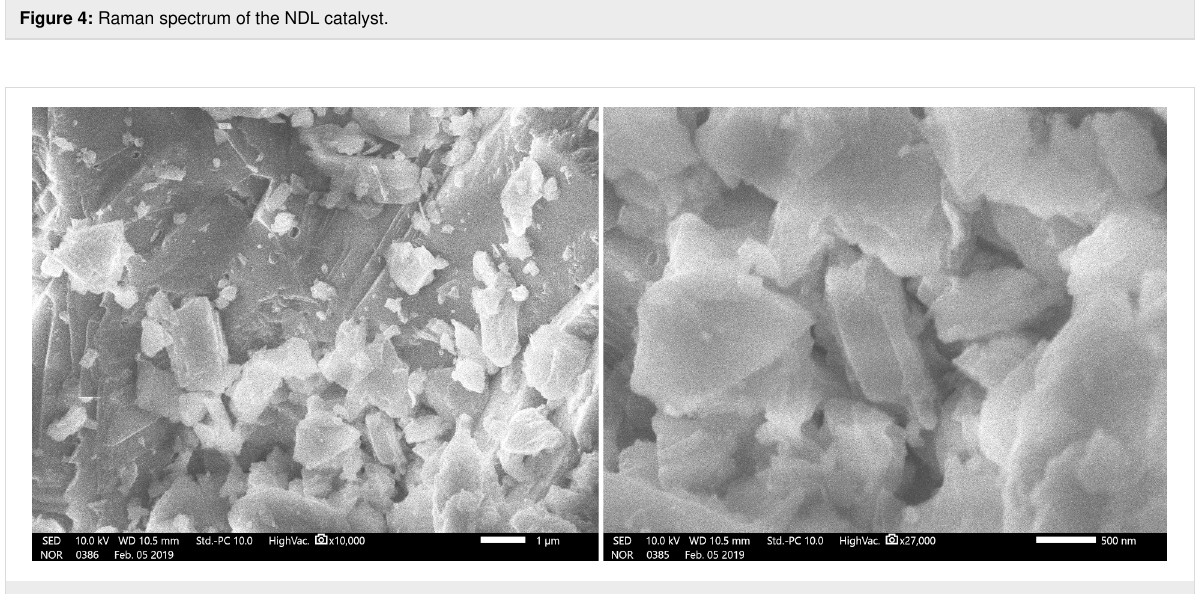
Figure 5: SEM images of the NDL